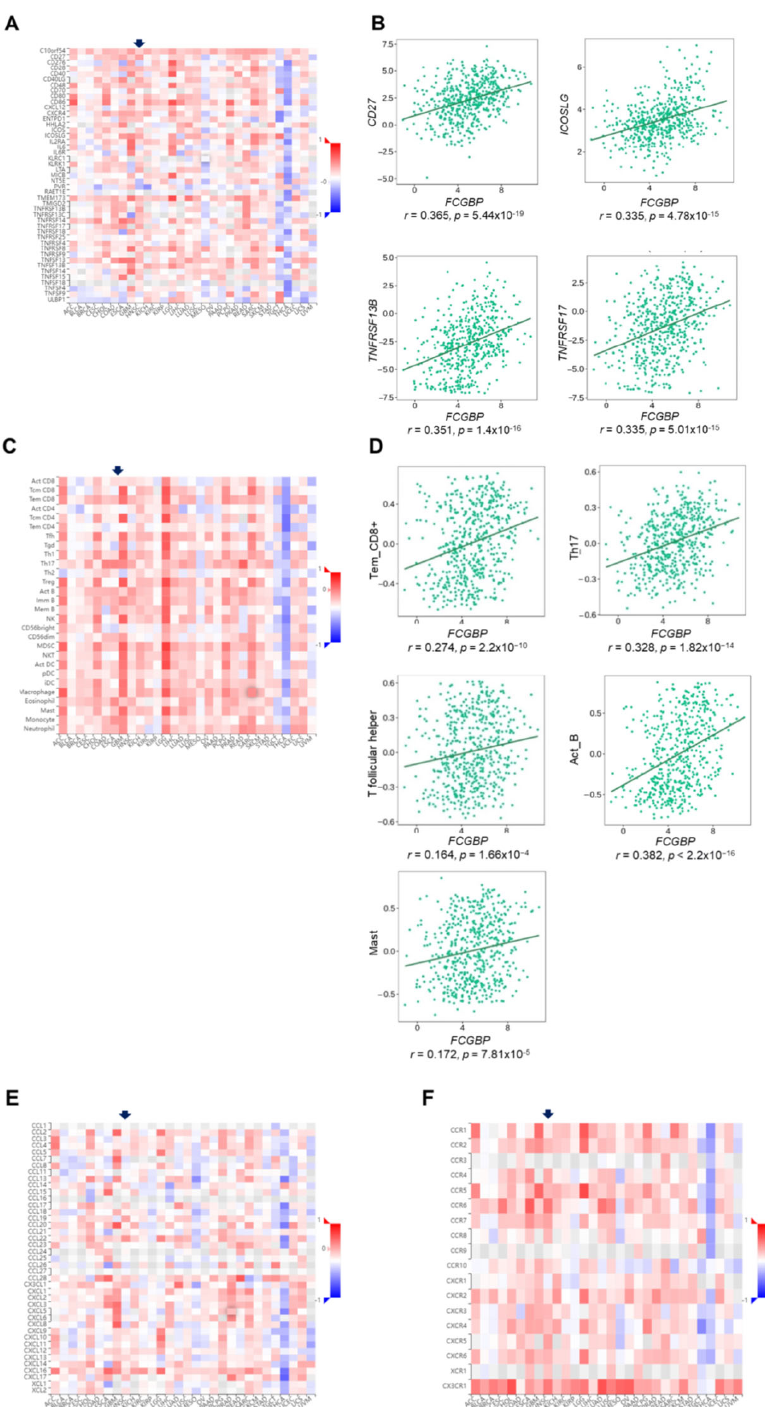
stimulators. The top four stimulators are CD27 molecule ( CD27 ) ( r = 0.365, p = 5.44 × 10 − 19 ), TNF receptor superfamily member 13B ( TNFRSF13B ) ( r = 0.351, p = 1.4 × 10 − 16 ), inducible T cell costimulatory ligand ( ICOSLG ) ( r = 0.335, p = 4.78 × 10 − 15 ), and TNF receptor superfamily mem- ber 17 ( TNFRSF17 ) ( r = 0.335, p = 5.01 × 10 − 15 ) (Figure 6B). These findings suggested that low FCGBP levels may relate to immune tolerance in HNSC since high FCGBP accompanied with better immune responses.